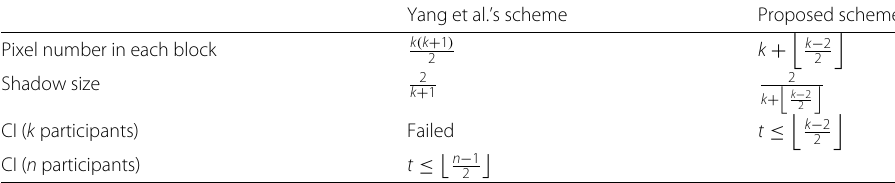
Table 1 Comparison between the proposed scheme and Yang et al.’s scheme Yang et al.’s scheme Proposed scheme Pixel number in each